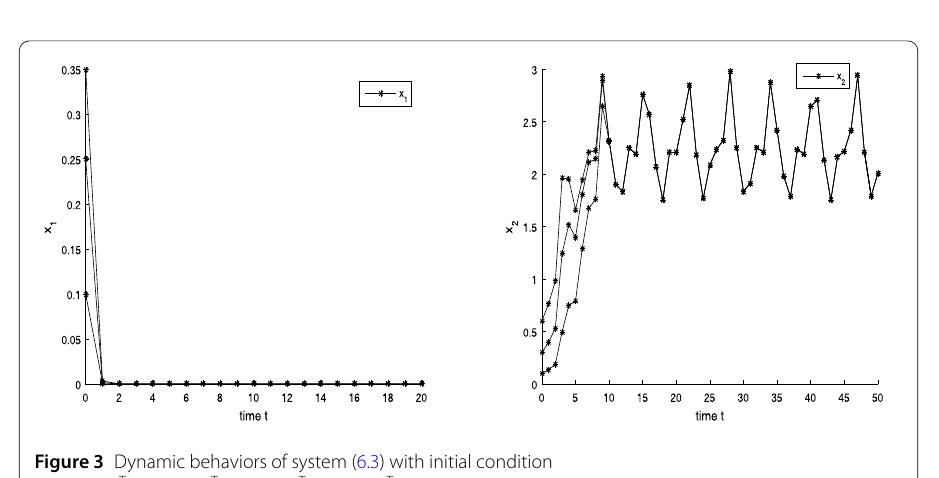
Figure 3 Dynamic behaviors of system (6.3) with initial condition ( x 1 ( t ), x 2 ( t )) T = (0.1,0.3) T ,(0.25,0.6) T ,(0.35,0.1)